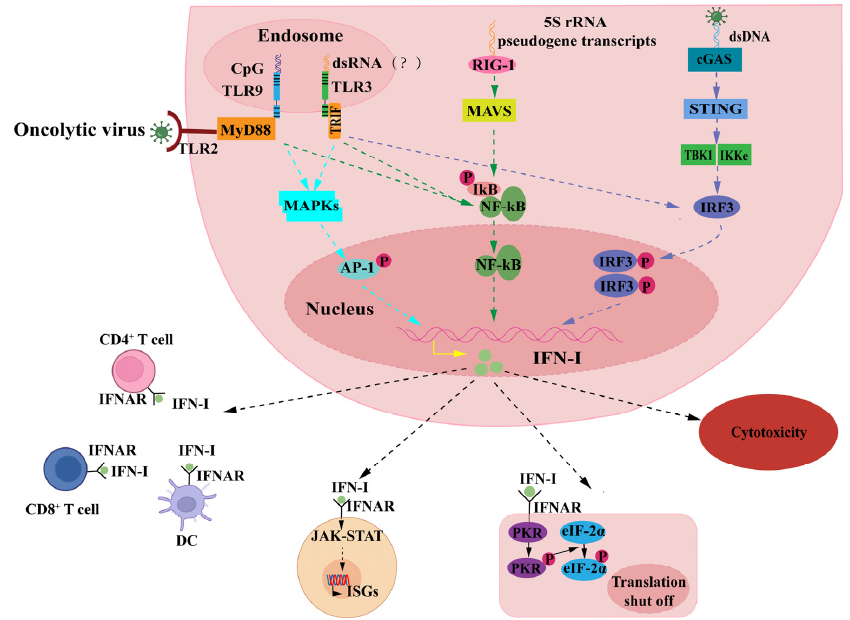
Figure 3. Antiviral effect of IFN-I. When viruses infect cells, they can either activate mito- gen-activated protein kinase (MAPK) phosphorylation in the nucleus or promote nuclear factor kappa B (NF- κ B) dissociation from I κ B via myeloid differentiation primary response protein 88 (MyD88) signaling after binding pathogen-associated molecular pattern (PAPMs) to Toll-like receptors 2 (TLR2). Herpes simplex virus type 1 (HSV-1) contains genomes rich in CpG DNA motifs and was demonstrated to activate type I interferon (IFN-I) secretion via TLR9 [75,76]. TLR3 can interact with double-stranded HSV-1, a non-transcribed RNA intermediate, during infection through a MyD88-independent pathway resulting in the activation of NF- κ B and interferon regulatory factor (IRF)-3 [77]. In addition, retinoic acid-inducible gene l-like receptors (RIG-I) recognize host 5S rRNA pseudogene transcripts but not HSV-1 genomic-derived RNA after activating IFN-I expression via the NF- κ B signaling pathway [78], and viral dsDNA interacts with cyclic GMP-AMP synthase (cGAS) via the cGAS-STING signaling pathway to initiate IFN-I expression. IFN-I binds to IFN receptor and induces more than 200 IFN-stimulated genes ( ISGs ) via Janus kinase/signal transducers and activators of transcription (JAK-STAT) pathway to produce comprehensive antiviral effects, and it activates relevant immune cells to promote antiviral immunity. This causes cellular transcriptional arrest through the activation of the protein kinase R (PKR) signaling pathway and exerts direct toxic effects on infected cells to resist viral